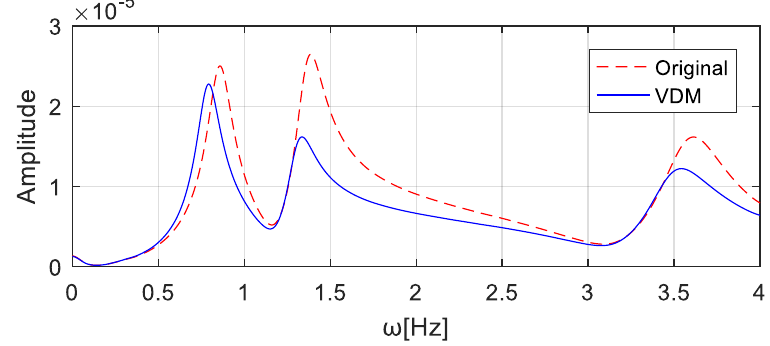
Figure 25. Acceleration frequency responses at T 1 wheel position with the virtual mass added to the wheel T 1 .